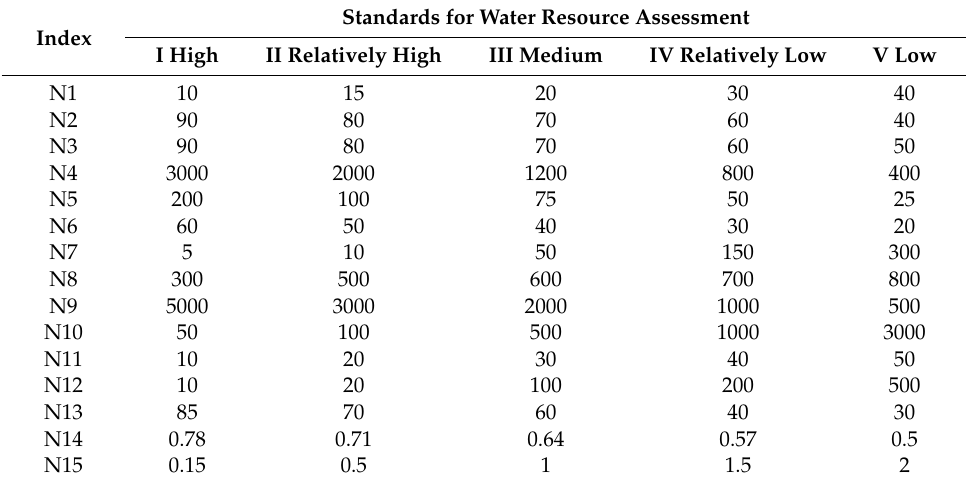
Table 3. The standards for the water resource value assessment system.